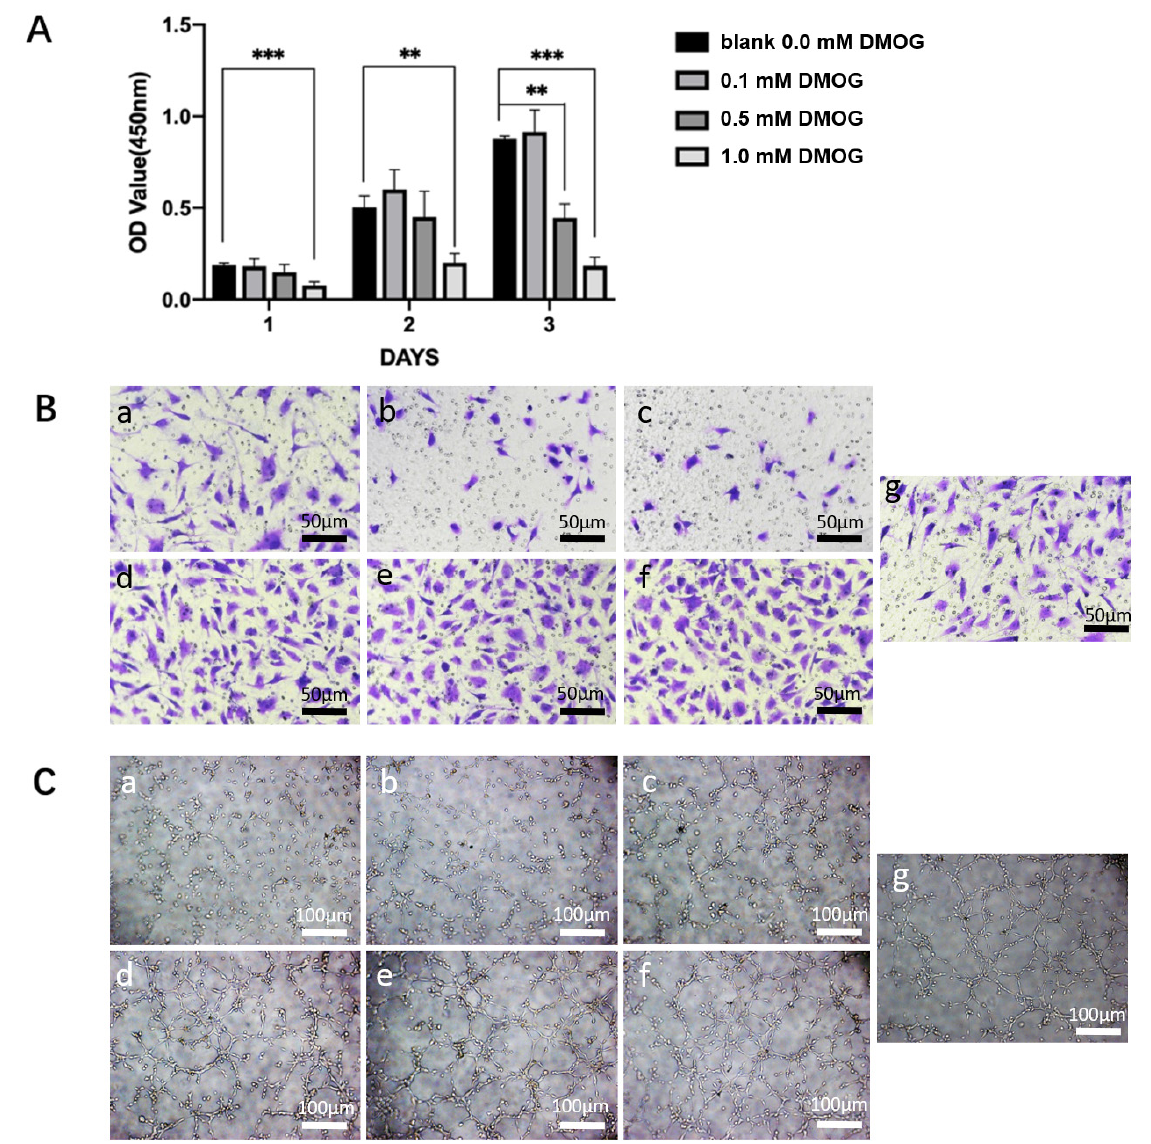
Figure 3. ( A ) Effects of different concentrations of DMOG on HUVECs. Compared with the control group, 0.1 mM DMOG can promote cell proliferation; while 0.5 mM and 1 mM DMOG can significantly inhibit cell viability. (**) = p < 0.01, (***) = p < 0.001. ( B ) effects of different chiral hydrogels ( a : LH, b : DH, c : RH) and three different chiral hydrogels containing DMOG ( d : LH-DMOG, e : DH-DMOG, f : RH-DMOG) on the migration ability of HUVECs. Compared with the control group ( g ), the hydrogels containing DMOG can significantly promote the cell migration rate; ( C ) effects of different chiral hydrogels ( a : LH, b : DH, c : RH) and three different chiral hydrogels containing DMOG ( d : LH-DMOG, e : DH-DMOG, f : RH-DMOG) on the tube-forming ability of HUVECs. Compared with the control group ( g ), the hydrogels containing DMOG can significantly promote the ability of endothelial cells to form tubes, and the number of lumens and branches increases